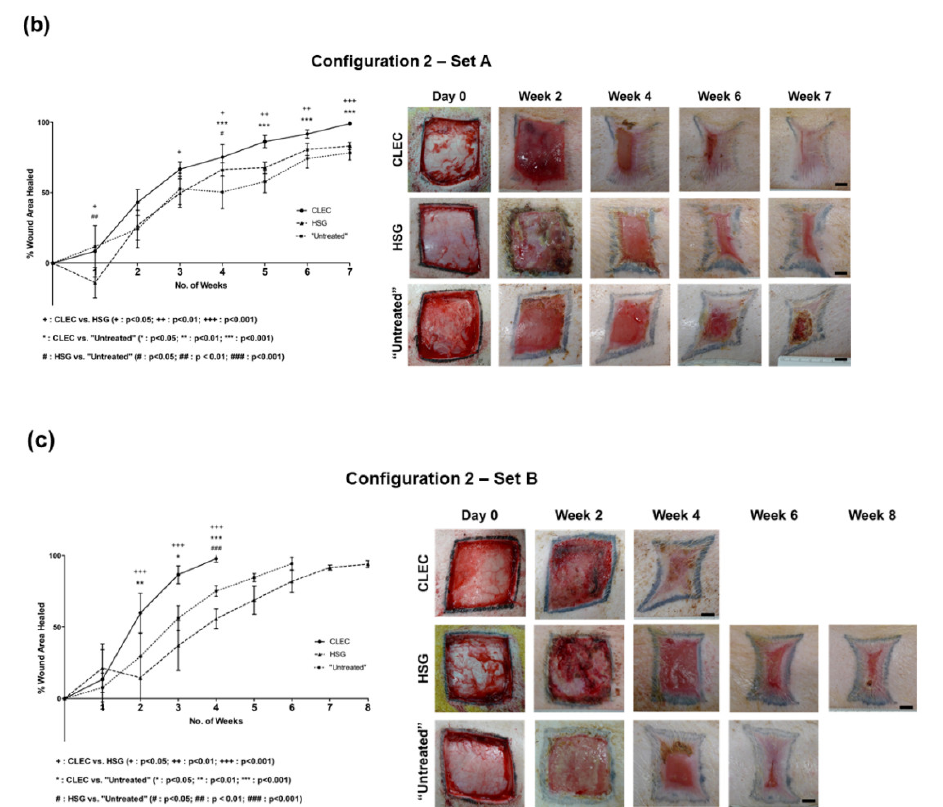
Figure 3. Percentage closure of weekly-measured wound area represented by mean ± SD based on ( a ) Configuration one with all the three treatment arms performed on a single pig (total pigs used: 2); ( b ) Configuration 2 Set A and ( c ) Configuration 2 Set B where only a single type of treatment was administered entirely to each pig (total pigs used: 6). The three treatment arms compared were CLEC, HSG, and standard dressings (“untreated”); n = 4 for configuration 1 and n = 5 for configuration 2. Statistical analysis was performed using one-way ANOVA—Bonferroni’s Multiple Comparison Test. Representative images of the stages of wound closure were shown for Configuration 2 at different time points with scale bar = 1 cm.